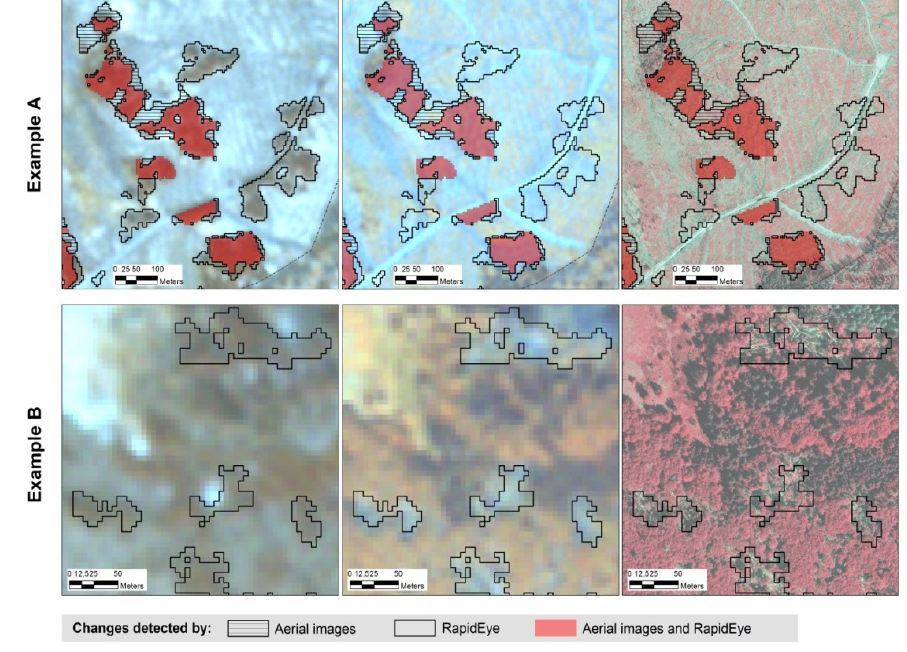
Figure 8. Two examples showing objects classified as “lost forest” overlaid on a RapidEye image from 19 April ( left ), a RapidEye image from 22 August ( middle ), and aerial images from 22 August ( right ). In example A, forest cover losses that were detected solely by RapidEye images are shown. In example B, the aerial image on the right clearly shows the windthrown trees detected solely by the analysis using RapidEye